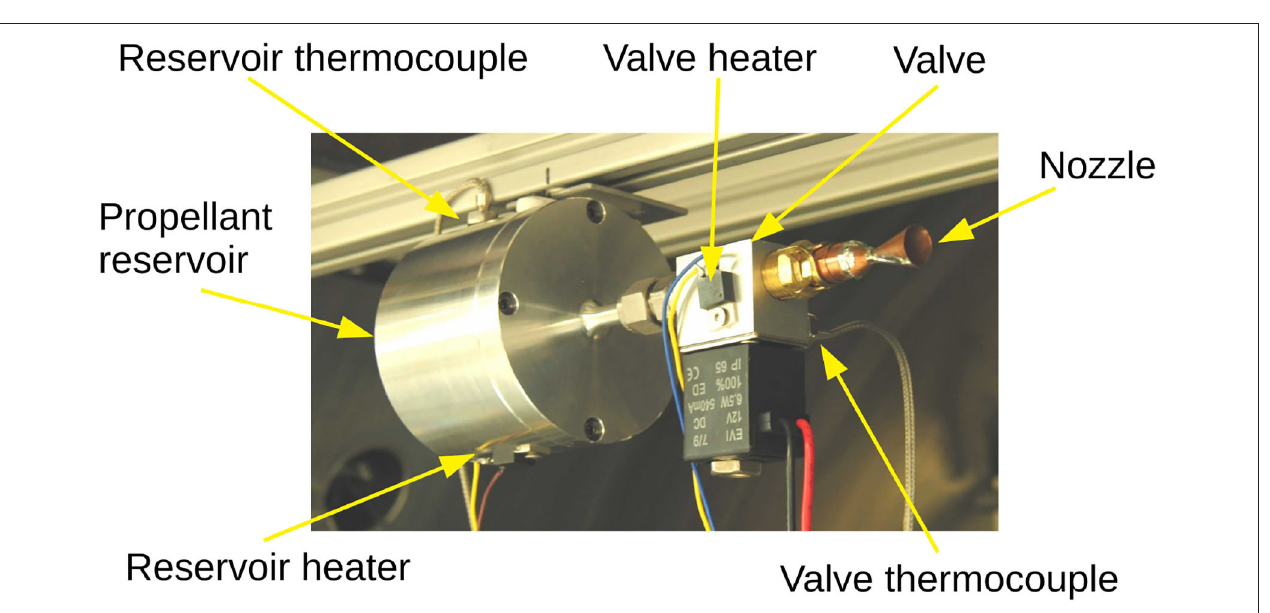
FIGURE 3 | Photo of the naphthalene thruster proof of concept (Figure 2) , mounted on the thrust balance within the Wombat space simulation chamber (Figure 4) with its main components